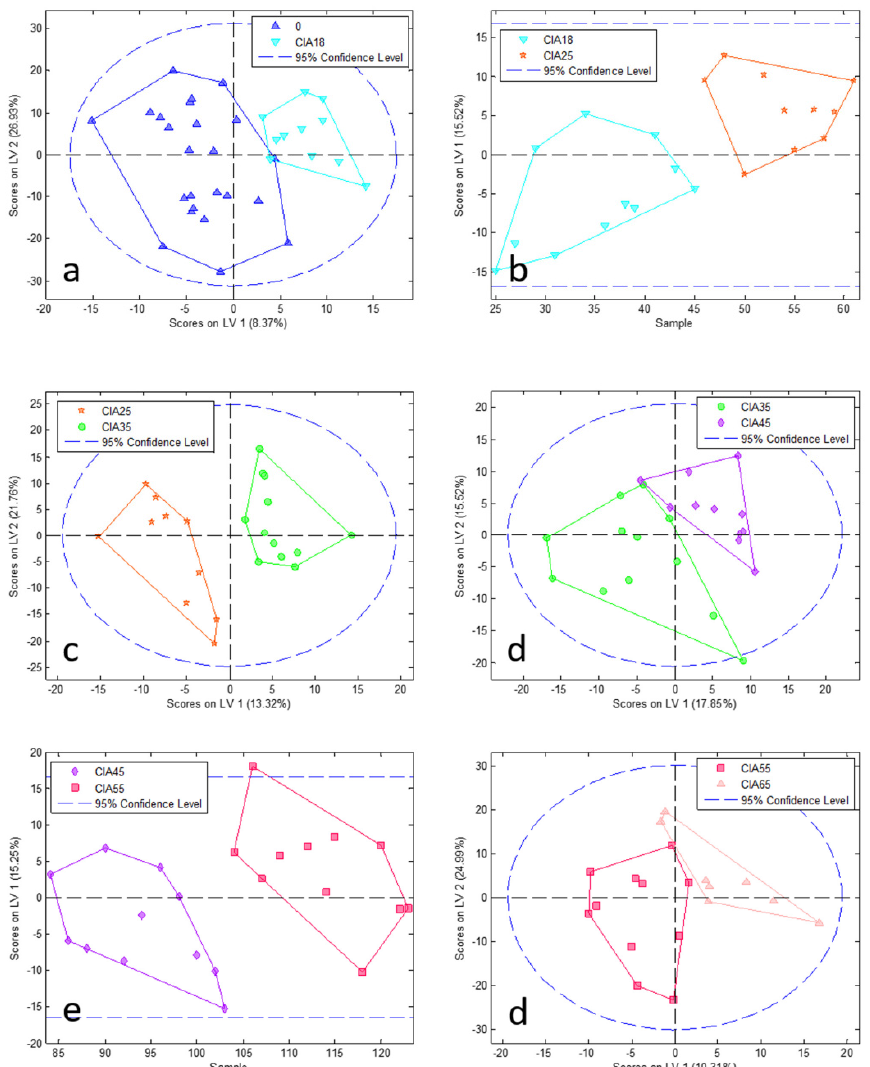
Figure 5. PLSDA pair analysis of CIA groups from one-time point to the next one. Graphics from ( a – f ) show comparison among 0 vs. CIA 18, CIA 18 vs. CIA 25, CIA 25 vs. CIA 35, CIA 35 vs. CIA 45, CIA 45 vs. CIA 55, and CIA 55 vs. CIA 65 days, respectively. 0: all animals before the experiment beginning (blue triangle); CIA18: CIA group 18 days after disease induction (light blue inverted triangle); CIA25: CIA group 25 days after disease induction (red star); CIA35: CIA group 35 days after disease induction (green circle); CIA45: CIA group 45 days after disease induction (purple diamond); CIA55: CIA group 55 days after disease induction (pink square); CIA65: CIA group 65 days after disease induction (light pink triangle). LV: latent variable. Table 1. Specificity and sensibility of NMR data after PLSDA model built obtained by the venetian blind test. Group Calibration Cross Validated CO vs. CIA Same Time Point Sensitivity Specificity Sensitivity Specificity